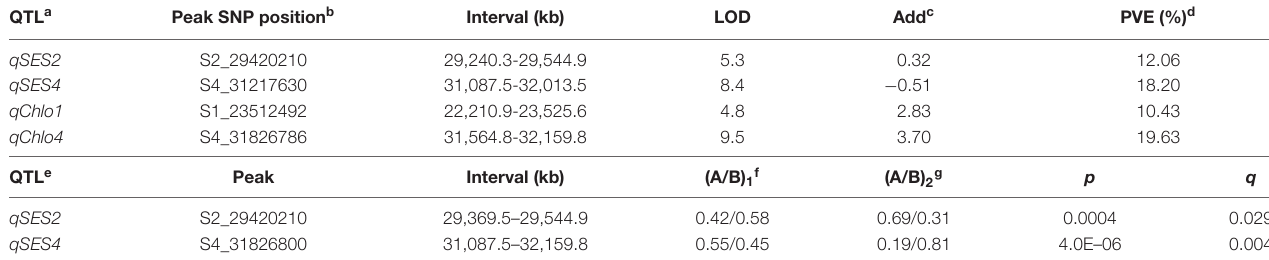
TABLE 4 | Identified QTL for salt tolerance at seedling